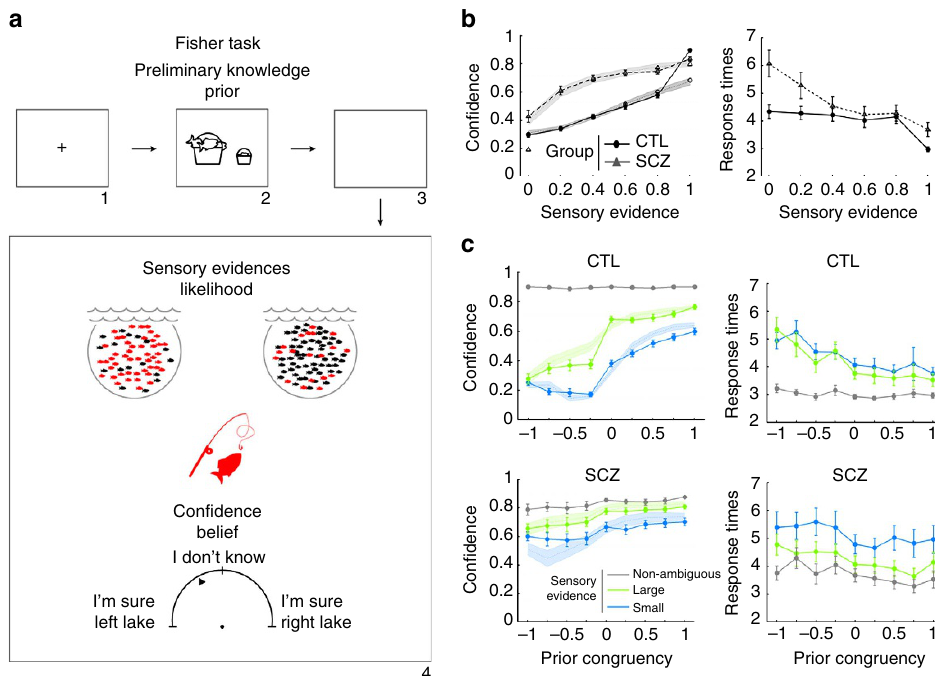
Figure 1 | The Fisher task: experimental procedure and behavioural performance. ( a ) Each trial can be decomposed into four steps (see ‘Methods’ section). After a fixation cross was presented (1), the prior information was provided (2). The size of the baskets represented the chance that the fisher caught a fish from the left or right lake. This prior was then removed (3), and the likelihood information was provided (4). The likelihood information consisted of the proportions of black and red fishes within both the left and right lakes. The participants reported their confidence that a red fish originated from one of the two lakes using a semi-circular scale. Confidence levels and RTs were recorded. ( b , c ) Mean confidence rates and RTs (in sec) in CTL participants ( n ¼ 25) and patients with SCZ ( n ¼ 25). The data are presented as the mean ± the s.e.m. ( b ) The effects of the sensory evidence on the absolute confidence and RTs in the SCZ and CTL groups. ( c ) The effects of prior congruency on the confidence levels and RTs in the SCZ and CTL groups. Three levels of sensory evidence were plotted: small amount of evidence ¼ likelihood of 0.2 or 0.4; large amount of evidence ¼ likelihood of 0.6 or 0.8; and unambiguous ¼ likelihood of 1. The circular inference model predictions ± s.d. (estimated with a noise term of s.d. ¼ 0.02 added to the likelihood) are shown as lines with shaded contours (see ‘Methods’ section and Supplementary Fig. 2 for predictions of the noiseless model for all